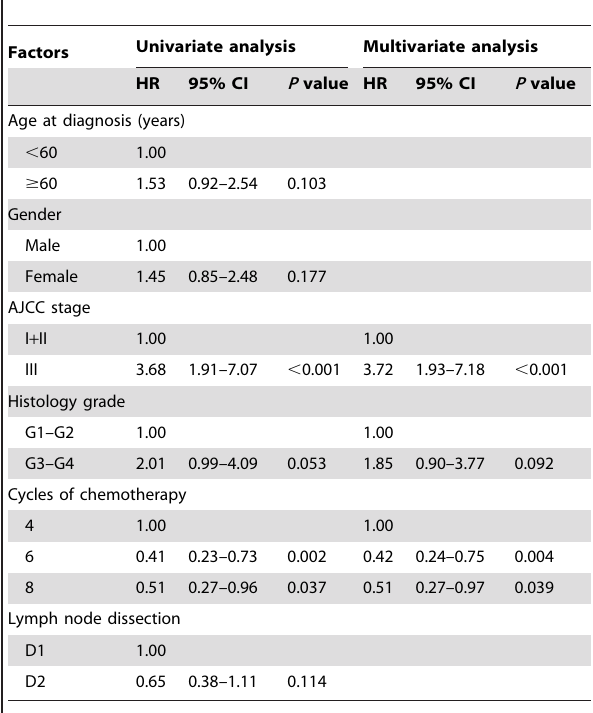
Table 2. Univariate and multivariate analysis for overall survival.